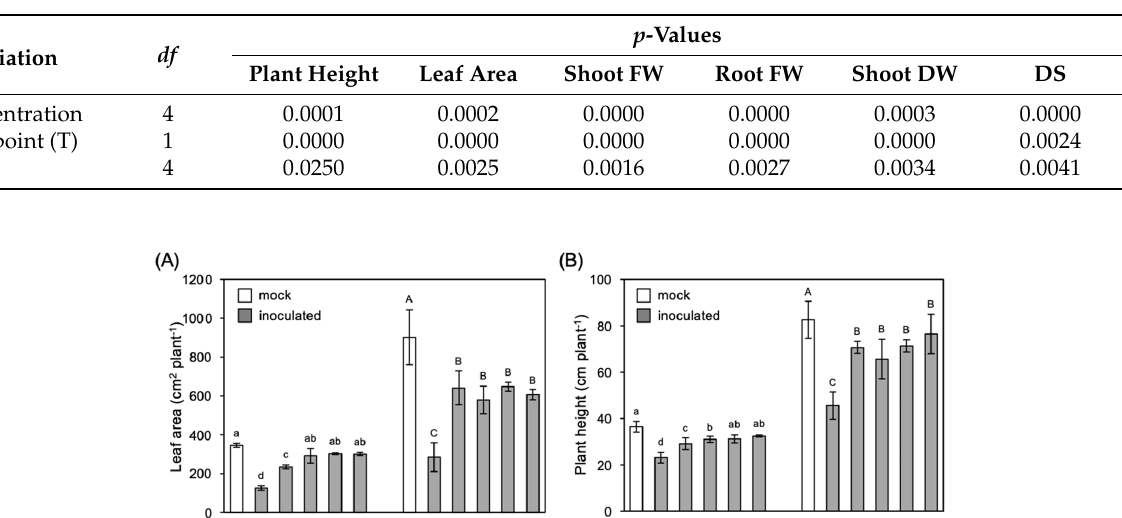
Table 1. ANOVA of the effects of Si concentration and sampling time point on plant growth and disease severity of infected plants.